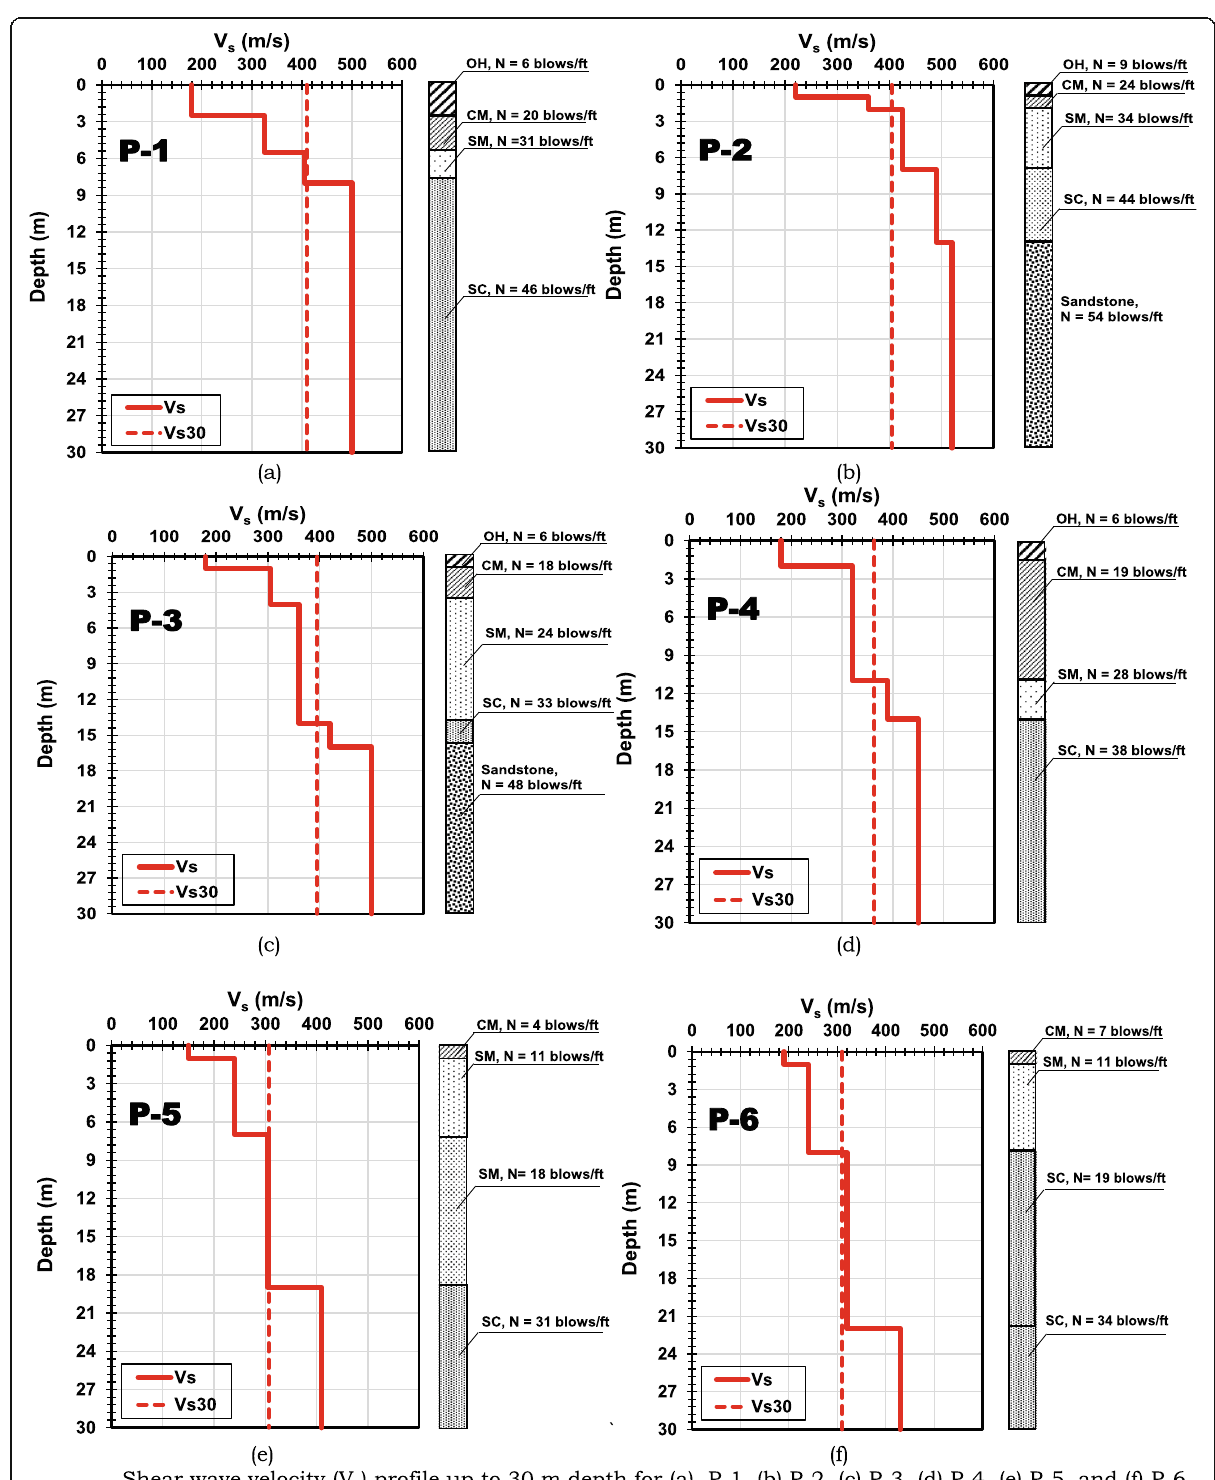
Fig. 9 Shear wave velocity (V s ) profile up to 30 m depth for (a) P-1, (b) P-2, (c) P-3, (d) P-4, (e) P-5, and (f)